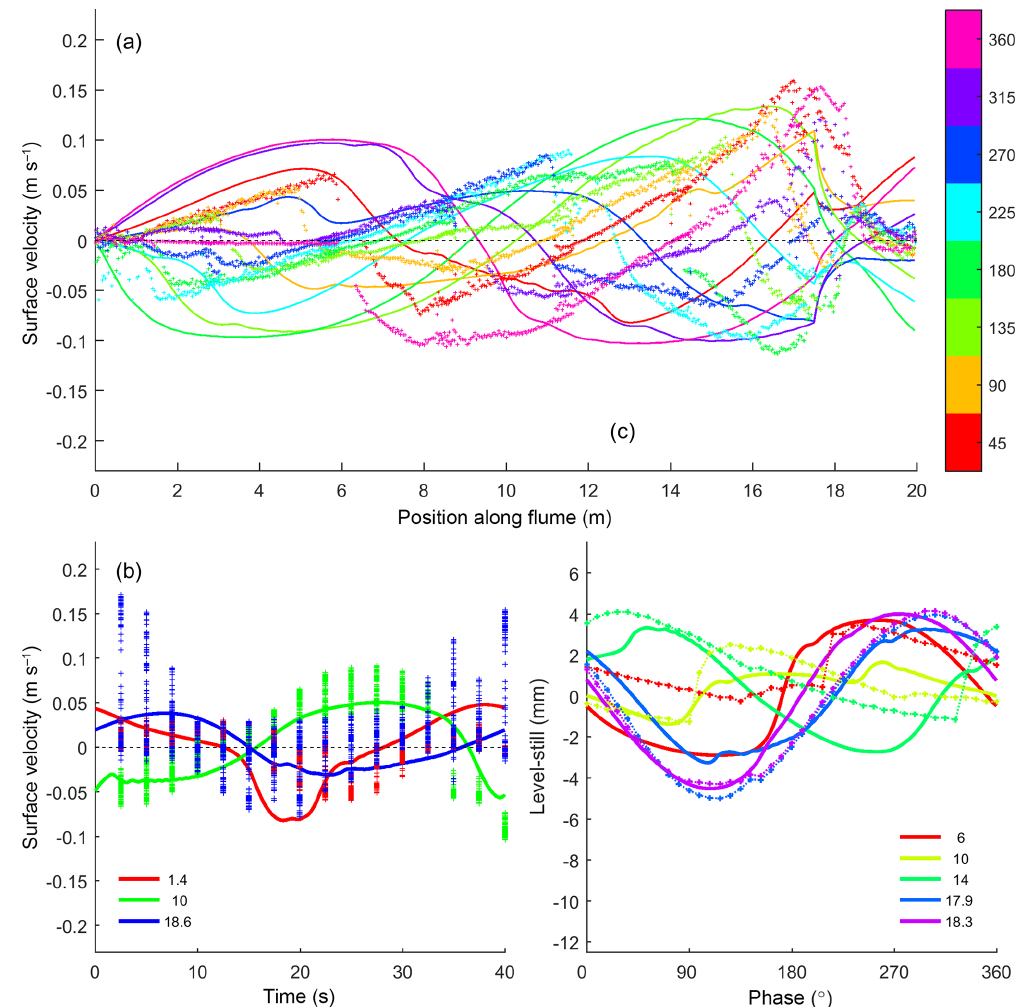
Figure 12. Flow data in an 18m sand-bed channel with a 2m long by 3m wide sea from PIV and modelled flow with a 40s period sea level fluctuation of 0.007m amplitude with the landward boundary closed. Note that the vertical axis range is half that of the tilting experiment. (a) Flow velocity at the water surface along the flume for selected phases of the tidal cycle. (b) Flow velocity at the water surface in one tidal cycle for selected positions along the flume measured from x = 0m, indicated in the legend. (c) Water level measured by acoustics as a function of phase in the tidal cycle for selected positions along the flume. Data are plotted as symbols and model results are plotted as drawn